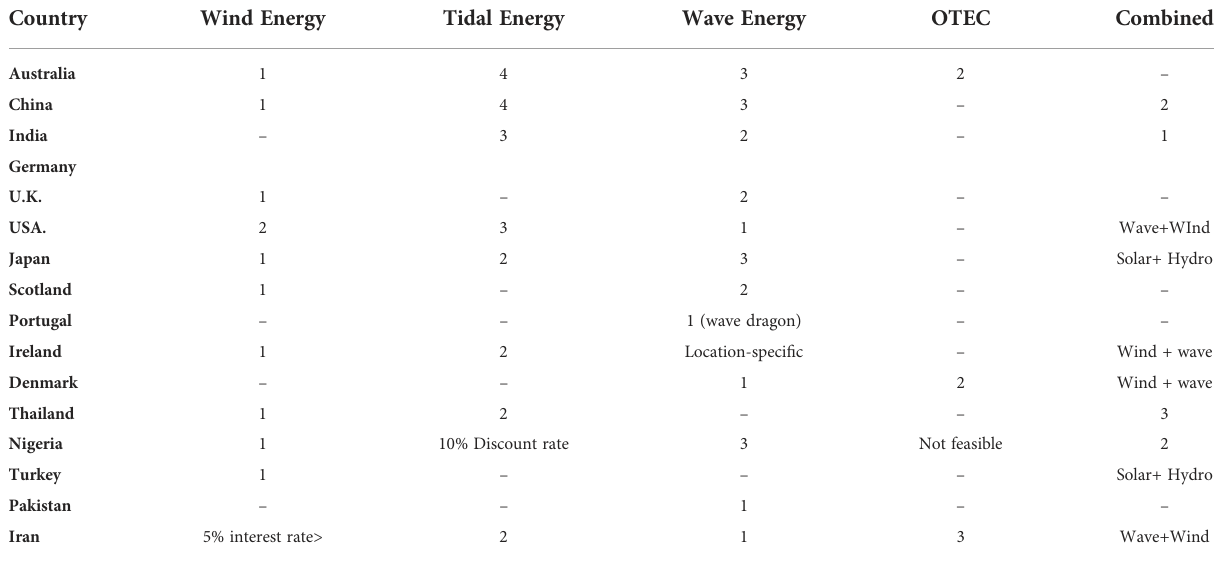
TABLE 1 Cost-effective analysis among various MRE types (ranking 1-4).